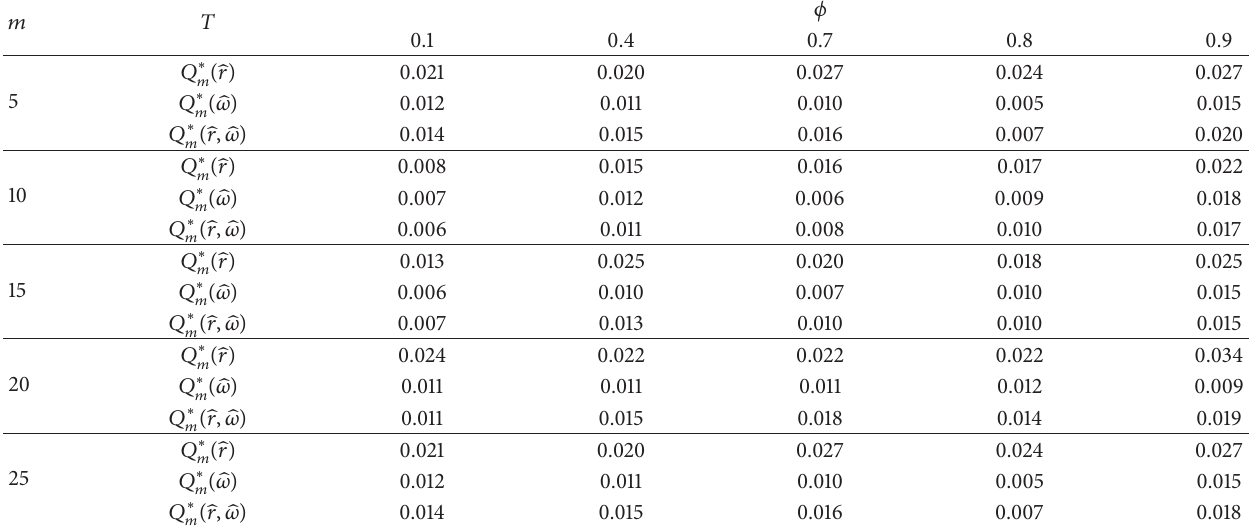
Table 2: Empirical size at 1% nominal size for an AR (1) process: 𝑦 𝑡 = 𝜙𝑦 𝑡−1 + 𝜀 𝑡 .